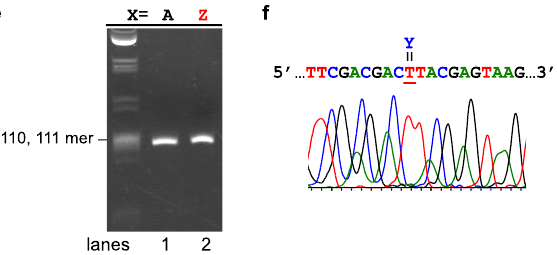
Figure 5. Behavior of the Z-base during replication catalyzed by DNA polymerase. ( a ) Sequence of the primer–template duplex used for single-nucleotide insertion. ( b ) Denaturing gel image of the products of single-nucleotide insertion by Klenow fragment DNA polymerase with incorporation of dNTP against A or Z in the template (lanes 2–9, 5 μM dNTP; lanes 11–18, 10 μM dNTP). ( c ) Steady- state kinetic parameters for the insertion of single nucleotide into a template–primer duplex. Assays were carried out at 37 °C for 2 min with 0.2–0.8 μM template–primer duplex, 0.025 units μL –1 of KF exo − , and 0.05–5 μM TTP in a solution (10 μL) containing 10 mM Tris-HCl (pH 7.9) buffer, 50 mM NaCl, 10 mM MgCl 2 , and 1 mM dithiothreitol (DTT). Each parameter was averaged from three data sets. ( d ) Sequences of template and primers for PCR. ( e ) Agarose gel analysis of products after PCR with Taq DNA polymerase. The reaction mixture contained 0.5 pM template, 1×ThermoPol ® Buffer (New England Biolabs), 0.5 µ M primers, 0.2 mM dNTPs, and 0.025 units µ L − 1 of Taq DNA polymerase in a volume of 50 μL. ( f ) Sequencing of products amplified from a DNA template containing a Z-base. The sequences of each amplicon (1.125 μg) were analyzed with 4 pmol of primer for both sense and antisense strands by an ABI PRISM 3100 Genetic Analyzer. Z-bases are highlighted in red.